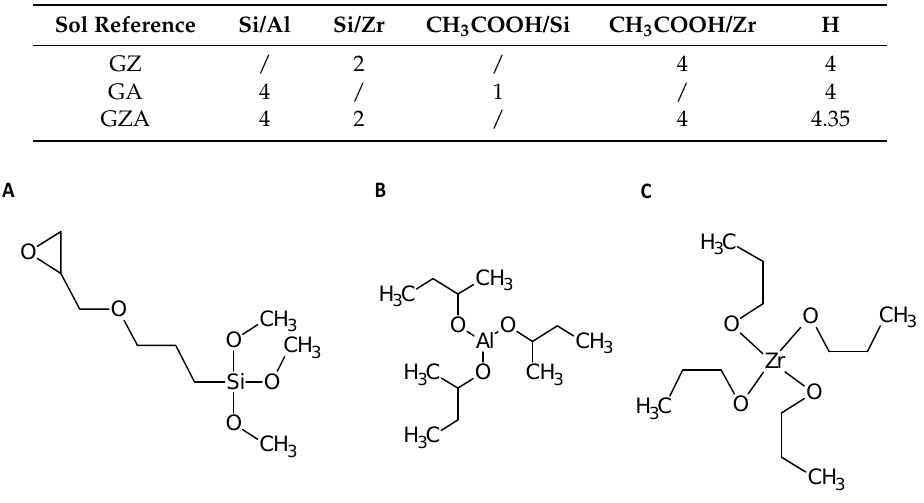
Table 5. Sol formulations in molar ratio.